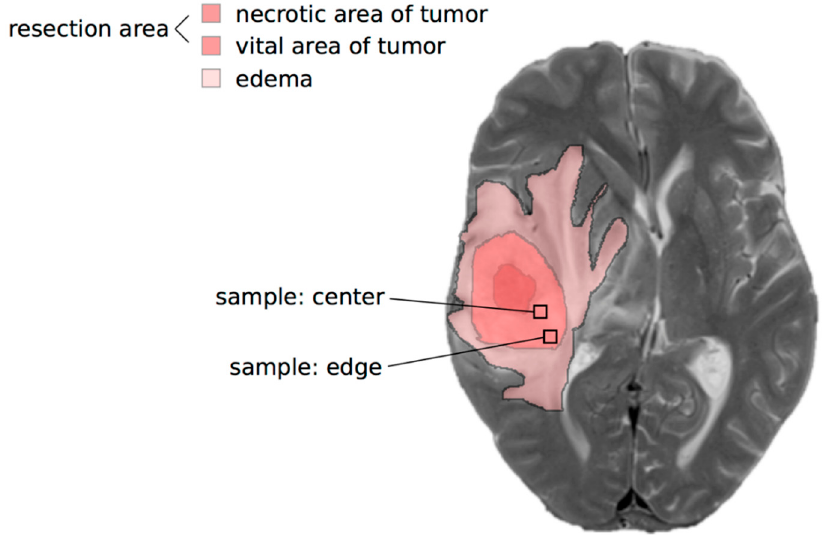
Figure 7. Typical topographic view of the glioblastoma resection area (vital area of the tumor (medium shade of red) and necrotic area (deepest shade of red)) and the surrounding edema (lightest shade of red), superimposed on an axial T2-weighted MR image (grey). Sampling areas from the center and edge of the vital parts of the tumor are indicated. Table 1. Overview of the clinical data of the examined patients (P: probe). The age, gender, the time span of symptoms before diagnosis, the setting: primary or recurrent tumor, the time span, till a relapse was diagnosed, as well as isocitrate dehydrogenase (IDH), O(6)-methylguanine-DNA methyltransferase (MGMT) promoter and 1p19q status was regarded. Two patients were included twice with primary and recurrent tumor, respectively (P11 primary = P29 recurrence ; P06 primary = P35 recurrence ). Symbol of